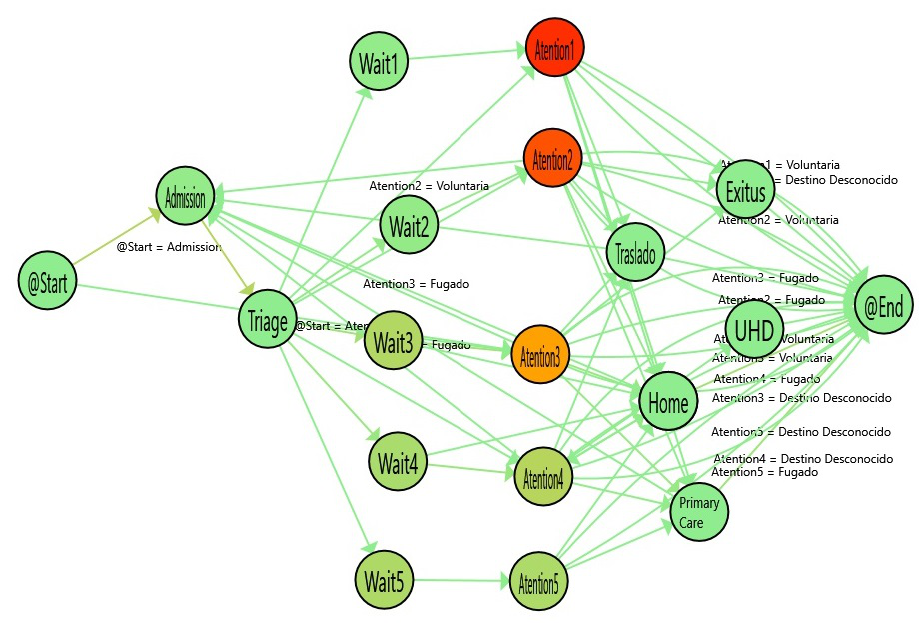
Figure 7. Flow of the ordinary discharge episodes for Q1. The colors in the nodes represent the average time spent in each